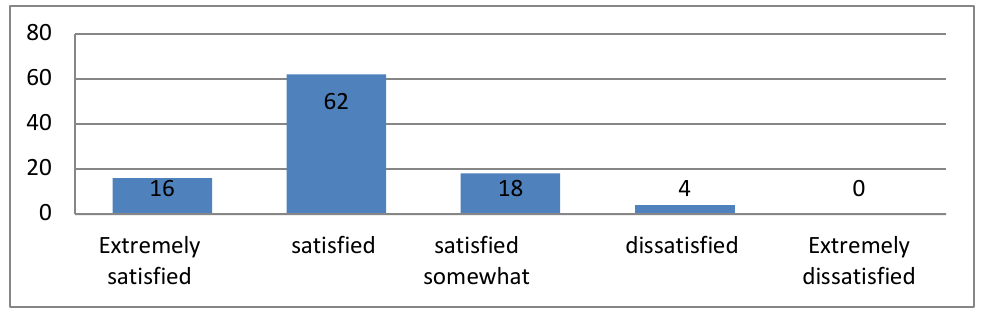
Figure 7: You have opportunities to make suggestion about issue effecting your work.